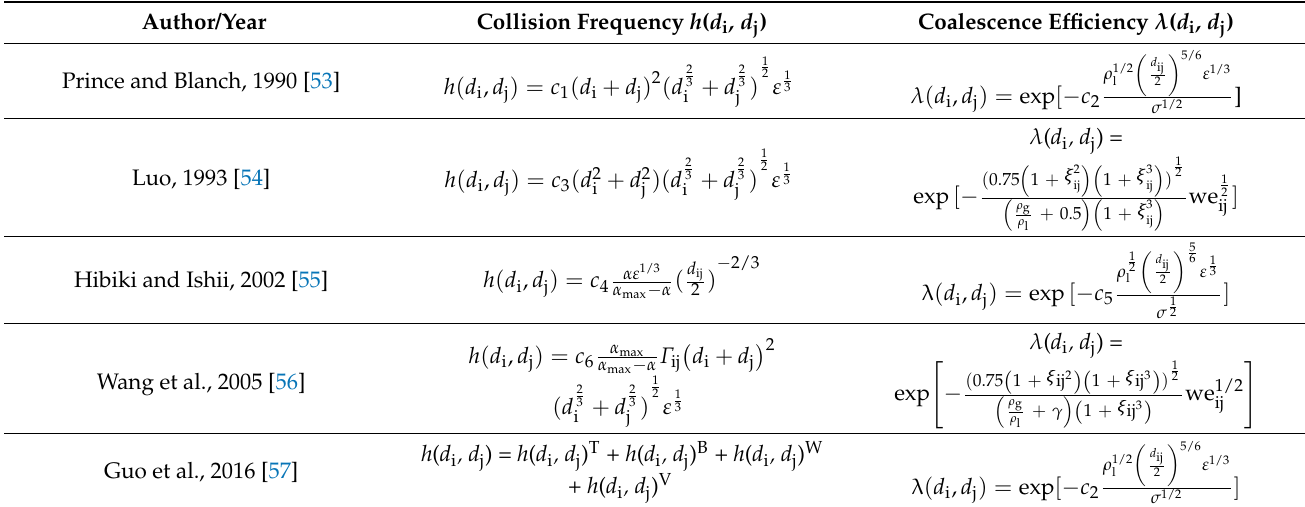
Table 5. Typical kernels of bubbles coalescence rate.